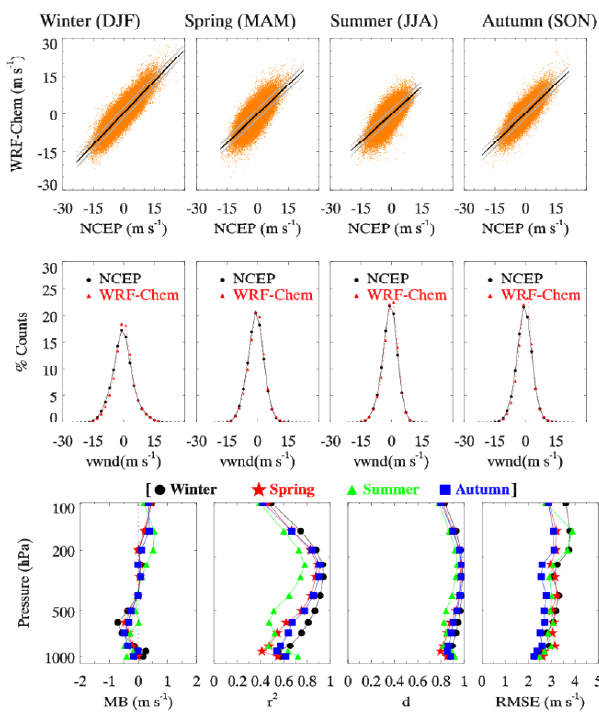
Fig. 9. The scatter plots (top panel) and the frequency analyses Figure 9: The scatter plots (top panel) and the frequency analyses (middle panel) of NCEP and 1042 (middle panel) of NCEP and model meridional wind component model meridional wind component at 2 m s -1 interval for 700 hPa during the four seasons of the 1043 at 2ms − 1 interval for 700hPa during the four seasons of the year 2008. The black lines in the scatter plots represent the linear fit year 2008. The black lines in the scatter plots represent the linear fit to the data while the grey 1044 to the data while the grey lines are the 95% confidence interval lines are the 95% confidence interval estimates in the fitted values. The vertical profiles (bottom 1045 estimates in the fitted values. The vertical profiles (bottom panel) of MB, r 2 , d and RMSE for each season are also shown. panel) of MB, r 2 , d and RMSE for each season are also shown. 1046